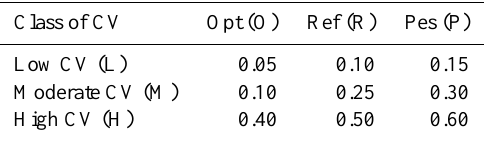
Table 1. Values used for CVs in three scenarios to assess the robust- ness of the uncertainty